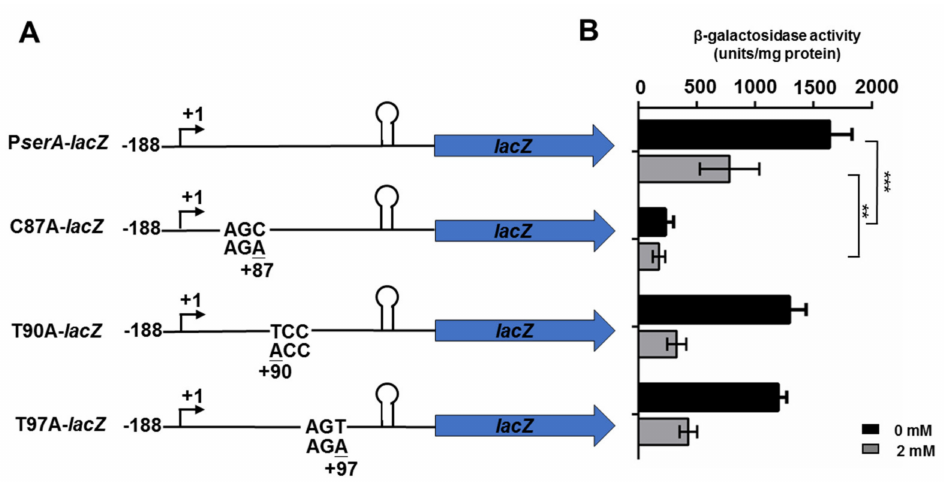
Figure 6. Scheme of mutation of specifier codon of serine and the β -galactosidase activities expressed from the leader- lacZ fusion carrying wild-type Ser codon sequence or the mutated codon sequence. ( A ) Scheme of mutation of specifier codon of serine and the leader- lacZ fusion carrying wild-type Ser codon sequence or the mutated codon sequence. ( B ) The β -galactosidase activities of P. polymyxa strains grown in minimal medium containing 0 and 2 mM L-serine. Results are representative of at least three independent experiments, mean values ± SDs were calculated from three sets of independent experiments. *** p < 0.001. ** for p <